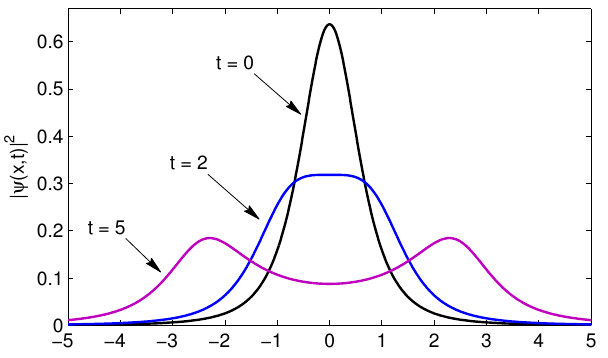
Figure 2. Time evolution of the Cauchy initial wave packet Equation (24) for the parameter ε = 1.